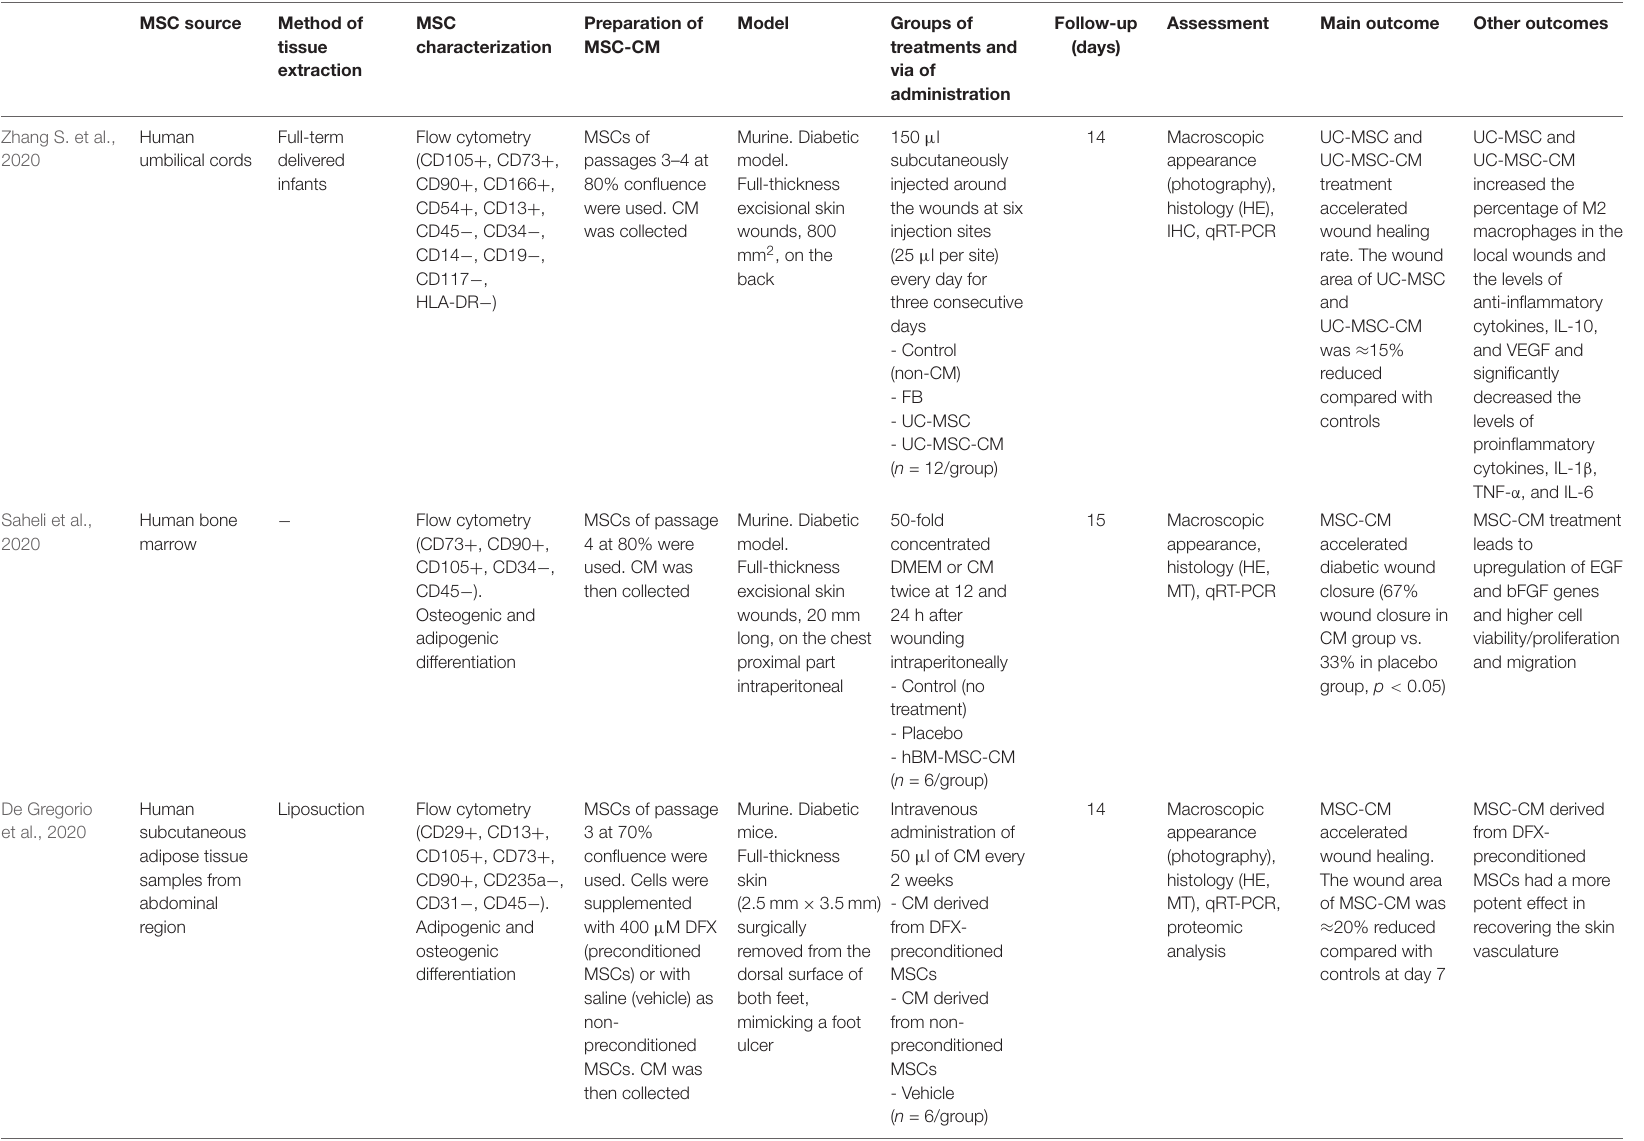
TABLE 2 | Studies regarding mesenchymal stromal cell-conditioned medium for treating diabetic wounds in animal